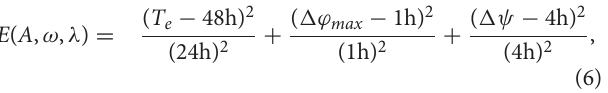
Frontiers in Physiology |